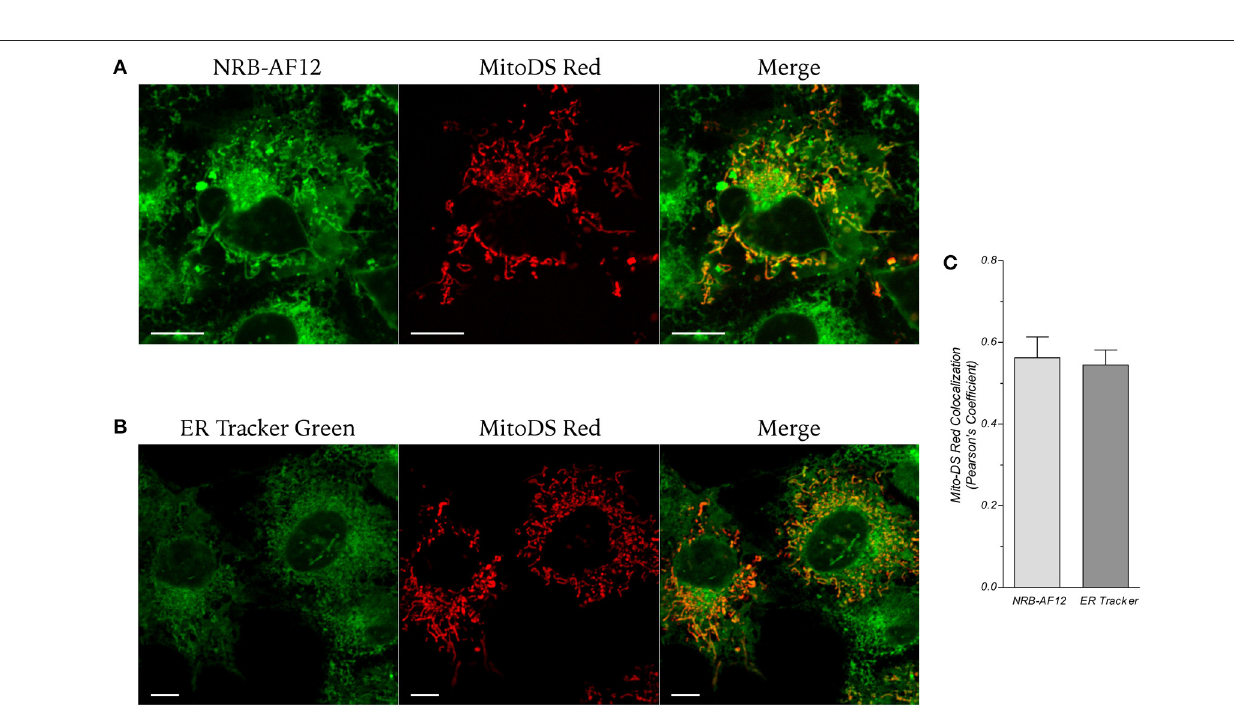
Frontiers in Pharmacology |